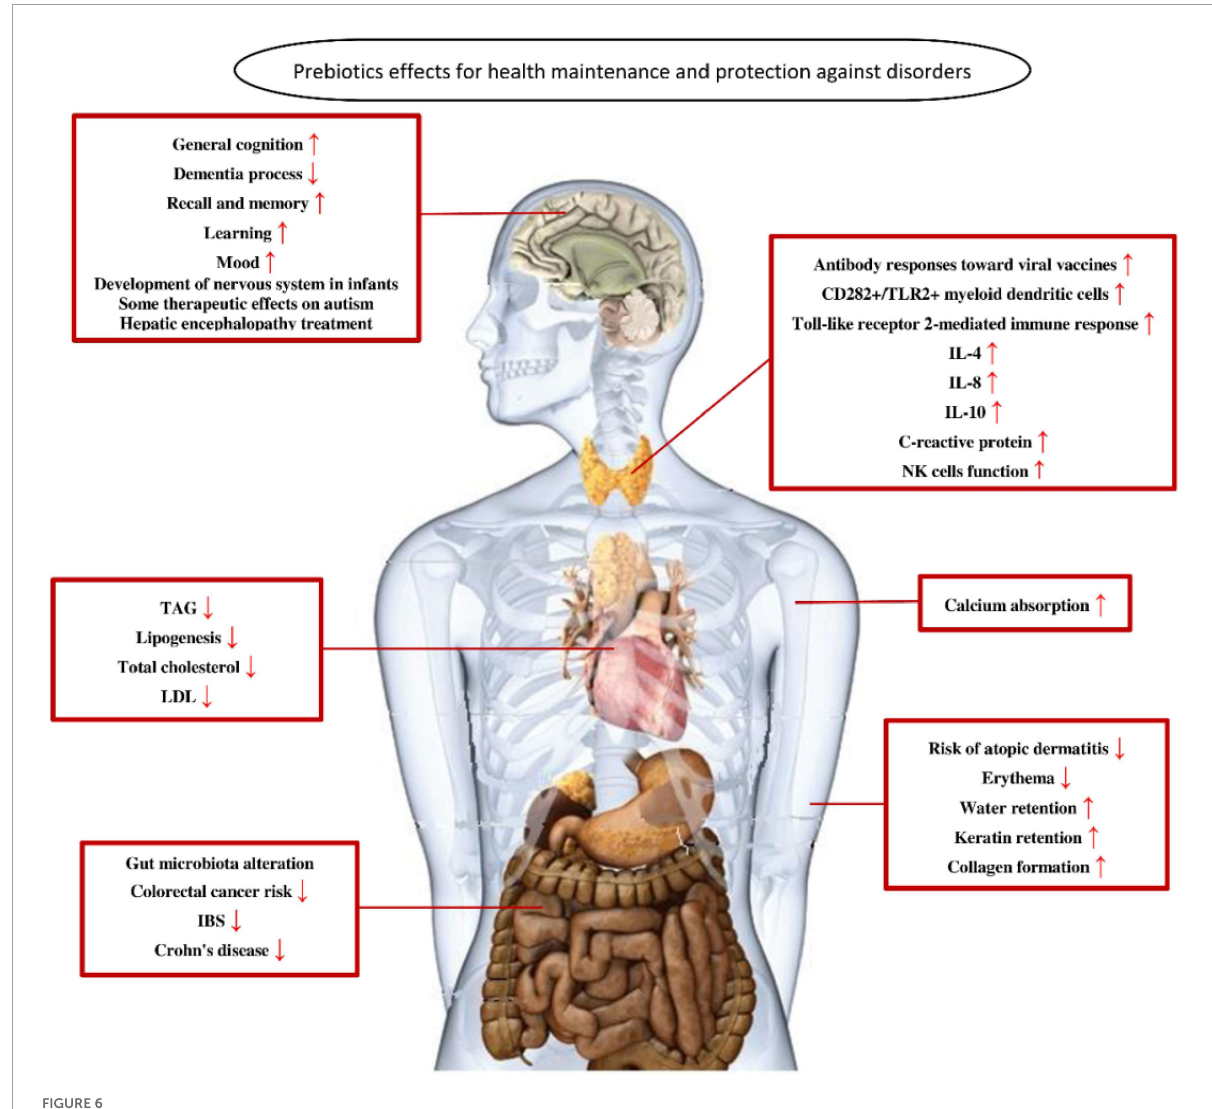
FIGURE6 The role of probiotics in maintaining health and preventing disorders of the